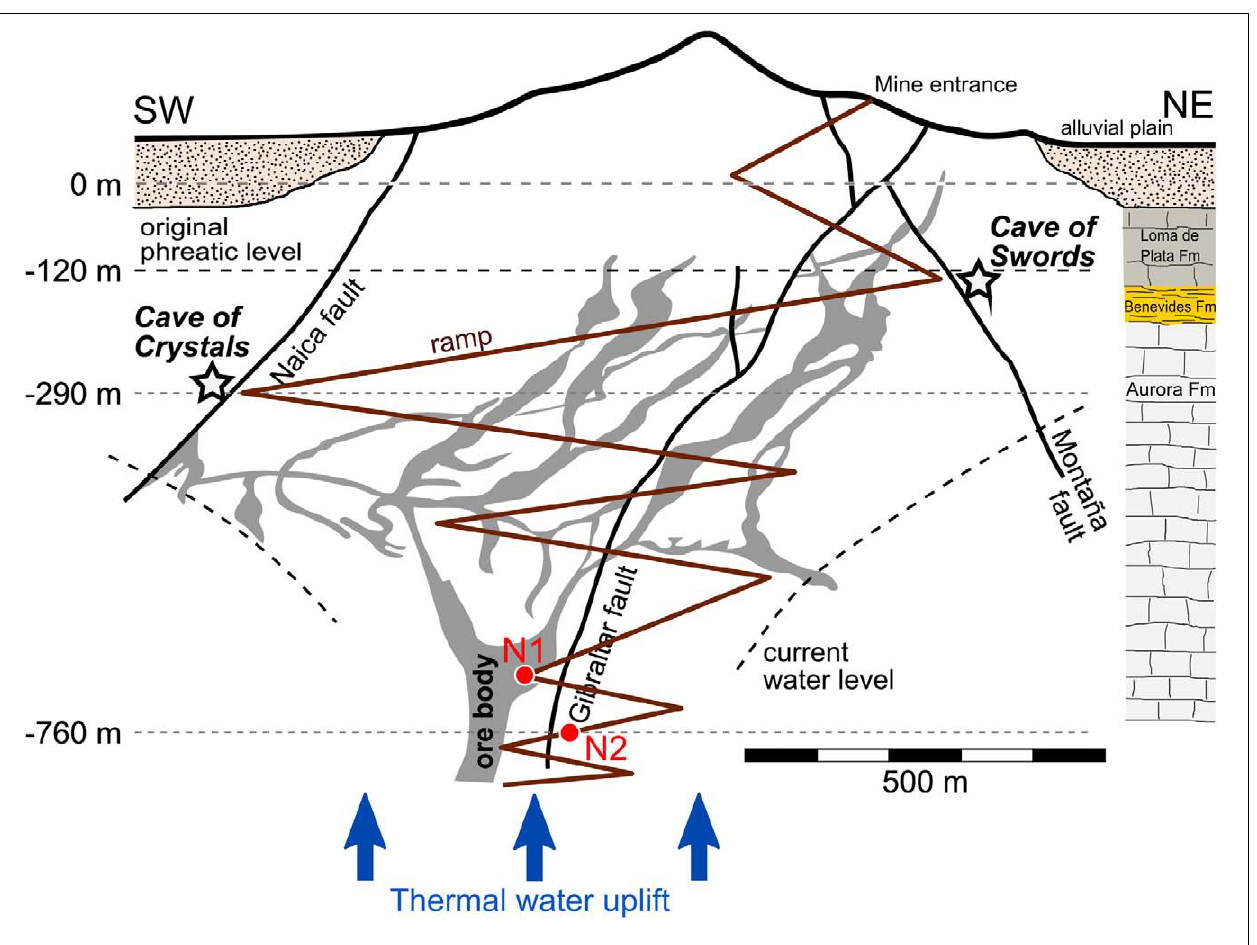
Cueva de la Espadas in 1910.The stratigraphic sequence on the right reports the lithology of a 1,150-m deep drillcore of the area (Garofalo etal., 2010).The figure was adapted from (Garcia-Ruiz etal., 2007) and (Forti and Sanna,